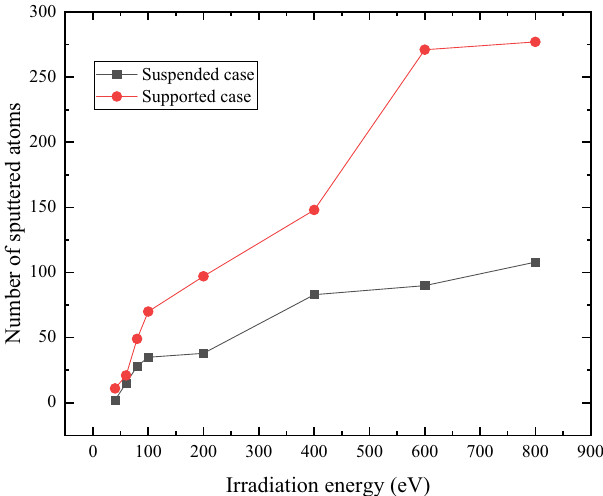
Figure 7. Variation of the number of sputtered atoms in MoS 2 of MoS 2 /graphene heterostructure for suspended case and supported case. The irradiation dose is 6.6 × 10 13 /cm 2 .